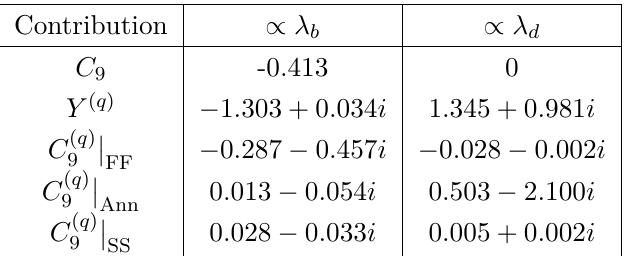
Table 5 . Breakdown of individual contribution at NLO for the D + → π + ‘ + ‘ − decay at s = 0 . 5 GeV 2